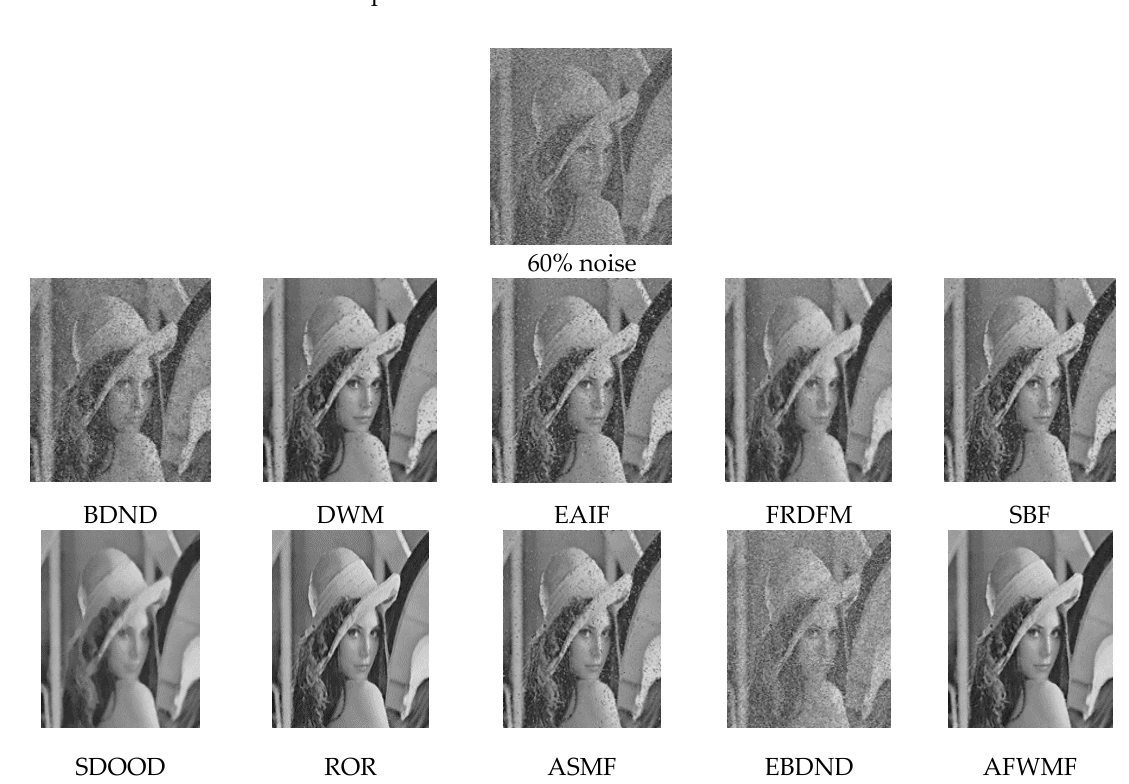
Figure 13. Repair map with a 60% random value of impulse noise for the Lena image.